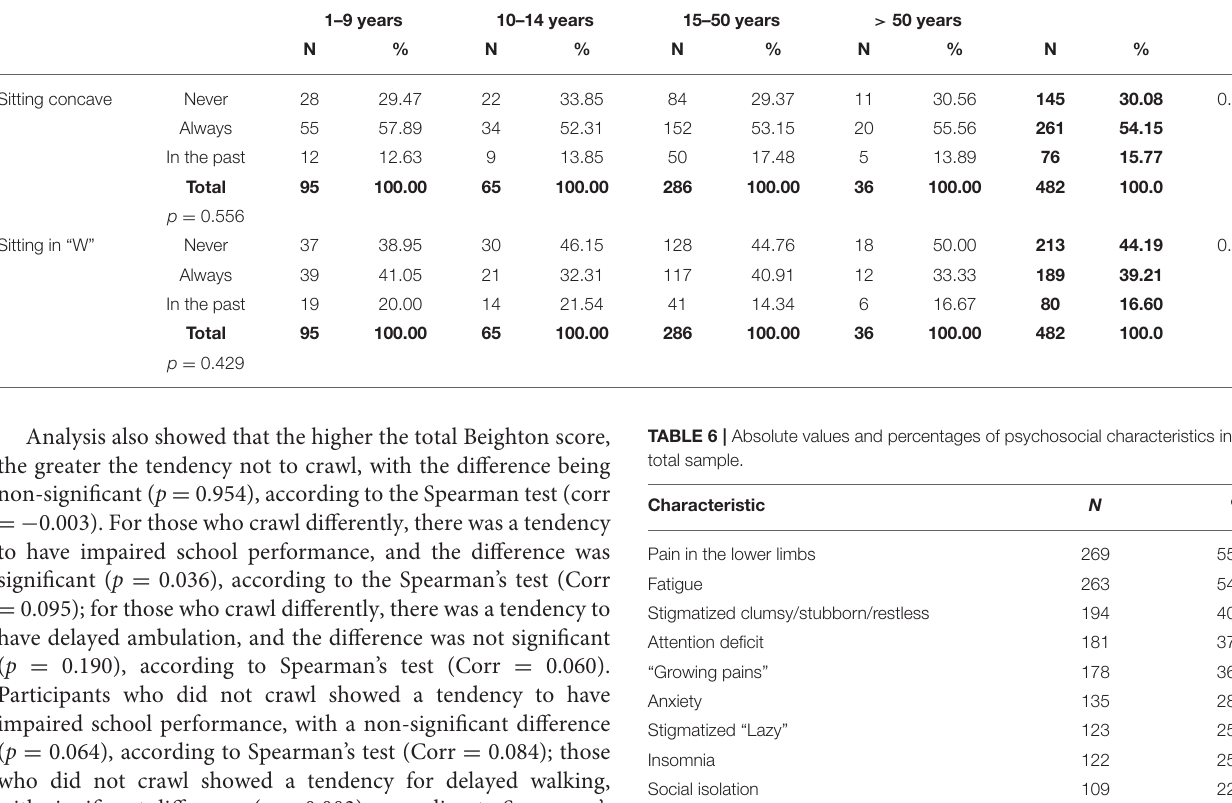
TABLE 5 | Absolute and percentage frequencies of body postures and skills never presented, always presented, and presented only in the past by age-group and in the total sample and p values. Variable